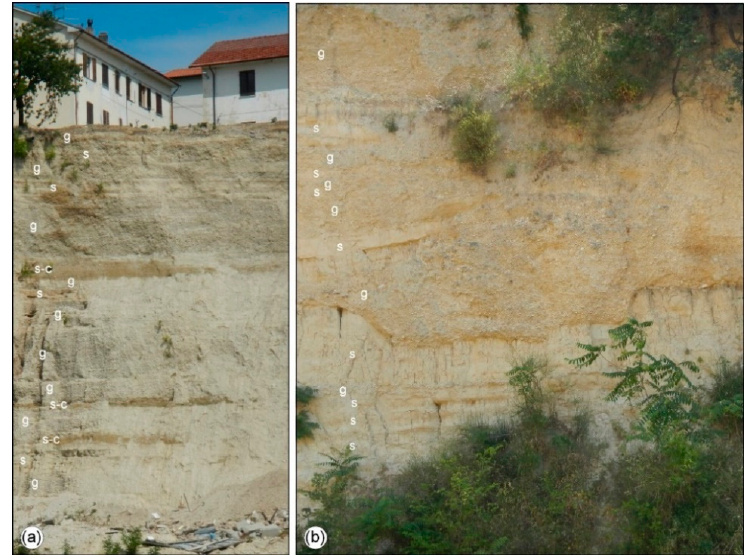
Figure 12. Lithological features of the terraced Middle Pleistocene alluvial fan deposits: ( a ) alternating gravel (g), sand (s) and clayey-sand (s-c) on the entire landslide scarp; ( b ) close up of the lithological features of the scarp.